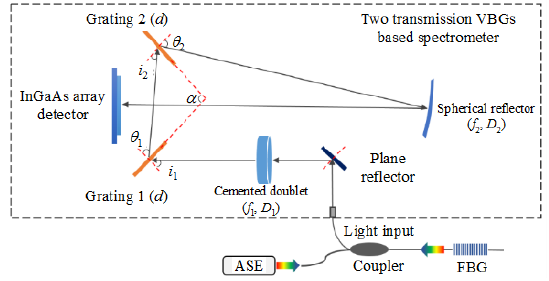
Fig. 1 Optical structure of two transmission VBGs based